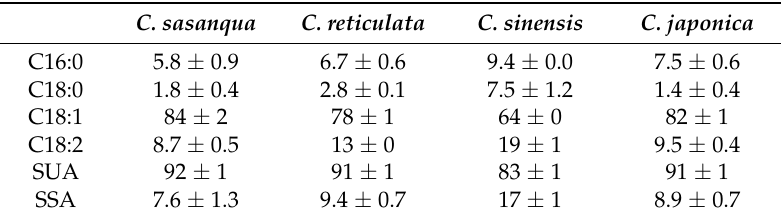
Table 5. Fatty acids content (%) in seeds from Camellia grown in Galicia (SUA, sum of unsaturated fatty acids, SSA, sum of saturated fatty acids).